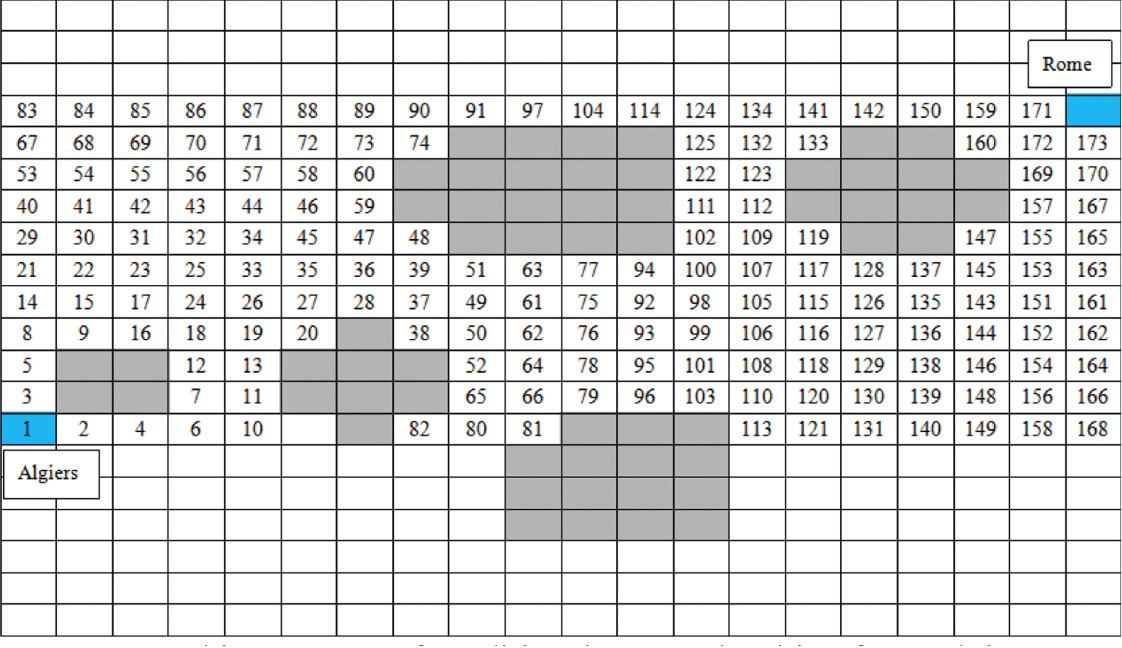
Figure 17: The searching process of traditional A-star algorithm from Algiers to Rome.